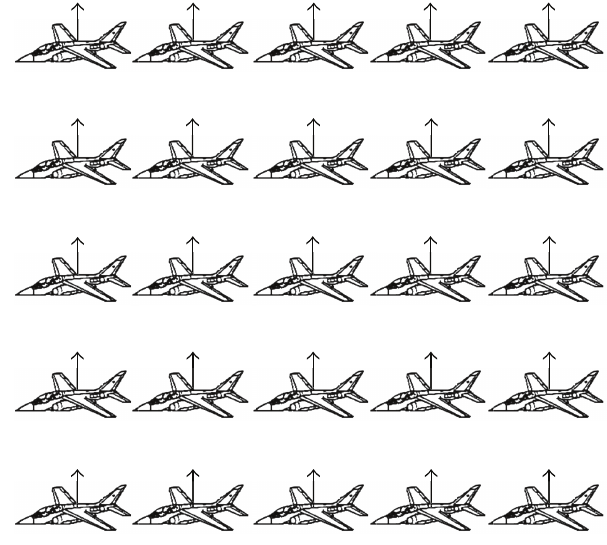
Figure 9: Tra ffi c received of a MANET of 4 UAVs.